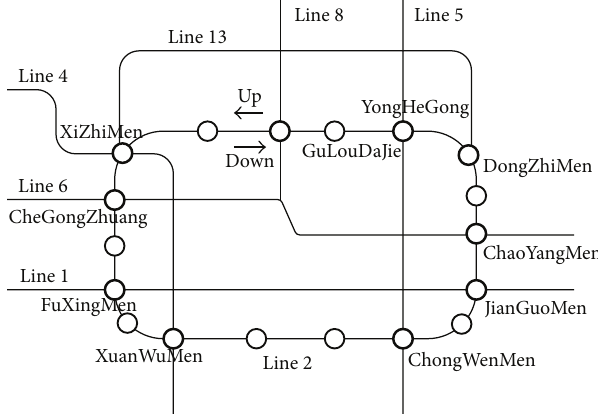
Figure 9: Sensitivity analysis of the variation of headways and dwell times.